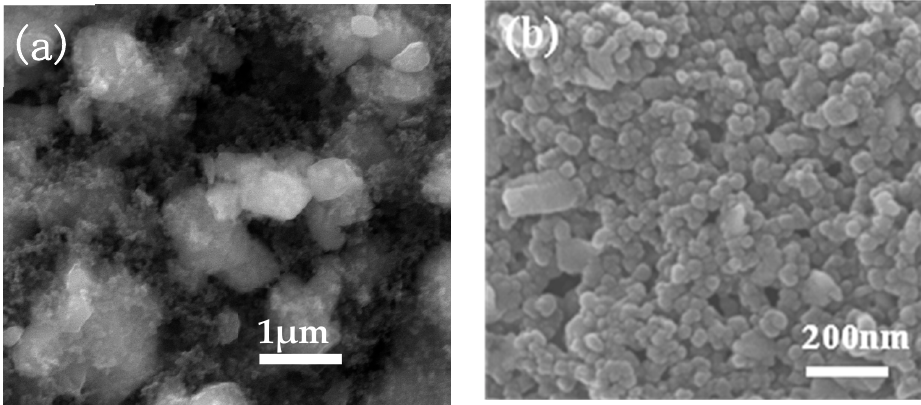
Figure 8. SEM micrographs of the powders obtained before and after mechanical alloying: ( a ) before mechanical alloying; ( b ) after mechanical alloying.